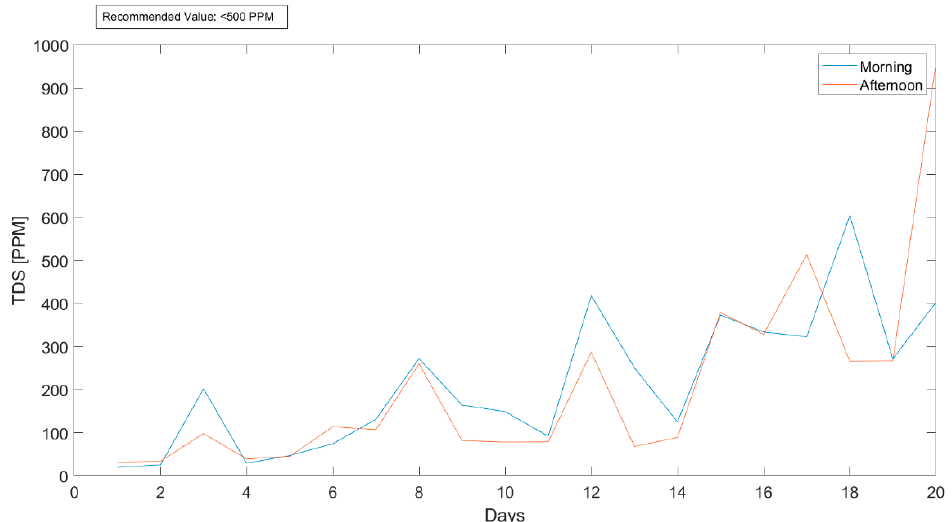
Figure 11. Total dissolved solids (TDS) Variation.